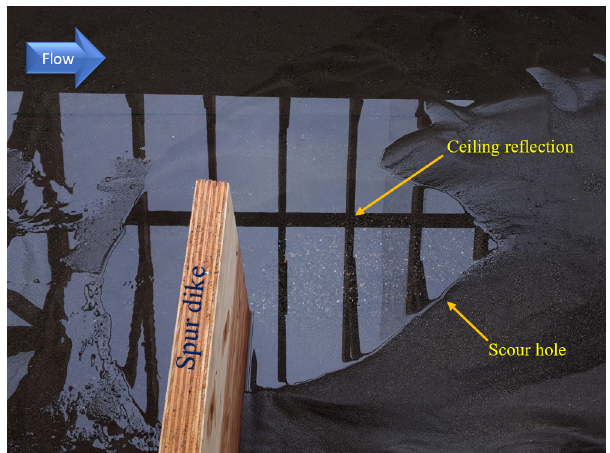
Figure 4. Plan view of the scour hole.